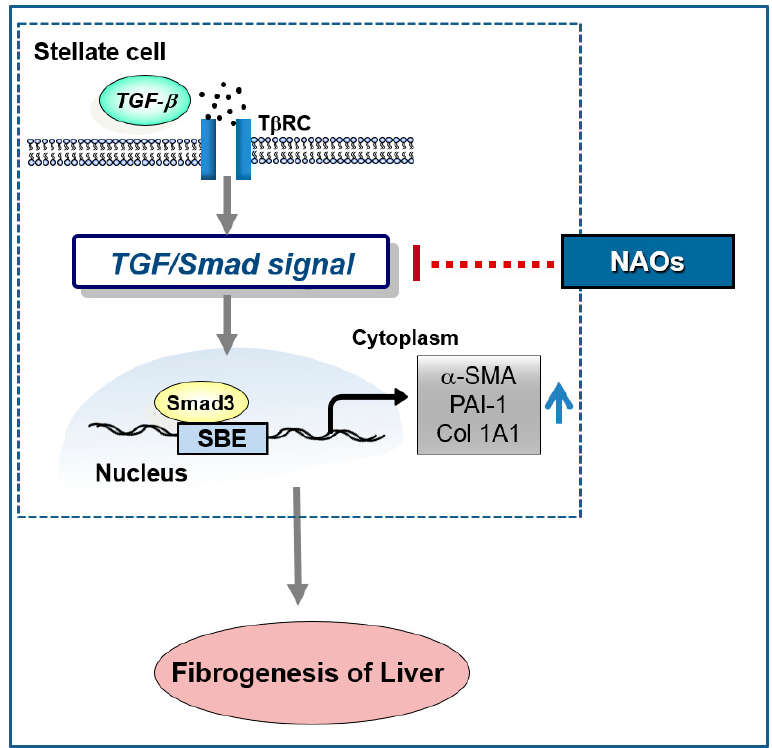
Figure 6. Schematic diagram demonstrating the mechanism through which neoagarooligosaccha- rides (NAOs) protect against hepatic fibrosis via inhibition of TGF- β /Smad signaling